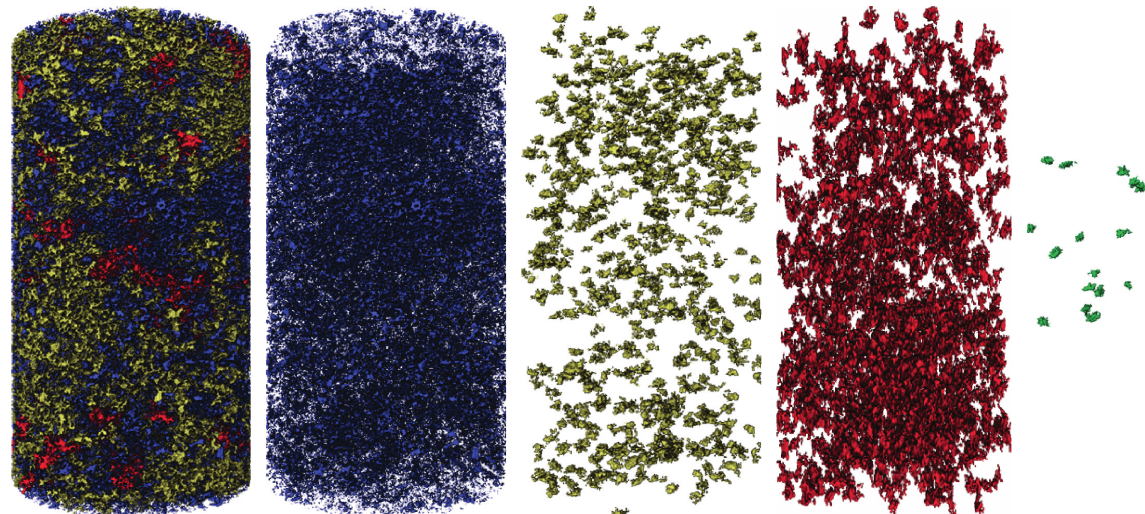
Figure 6: Spatial distribution of the pore structure of sample